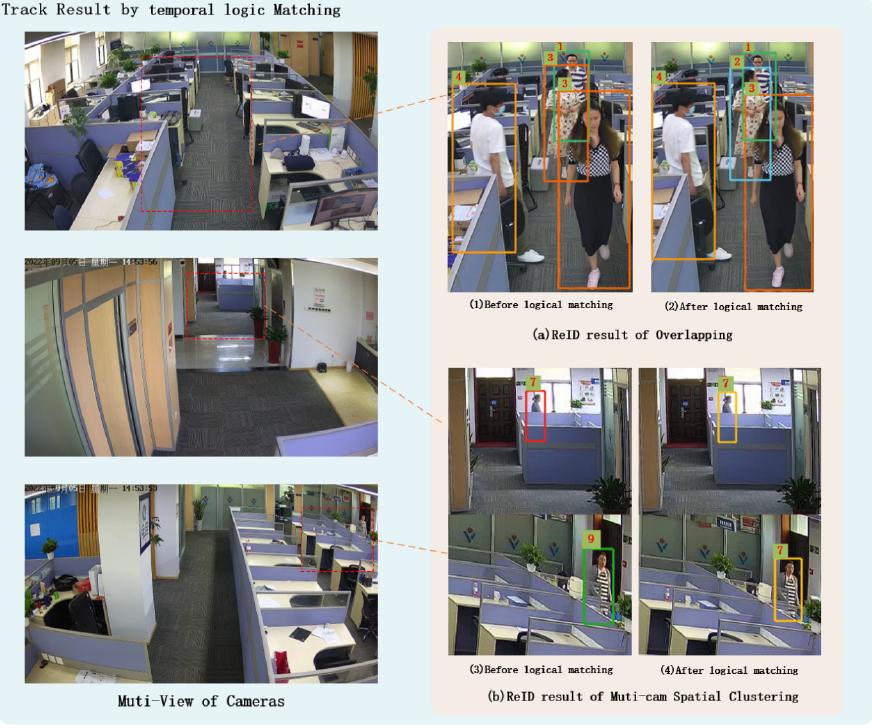
Figure 14. Graph of results after adding temporal logic matching.